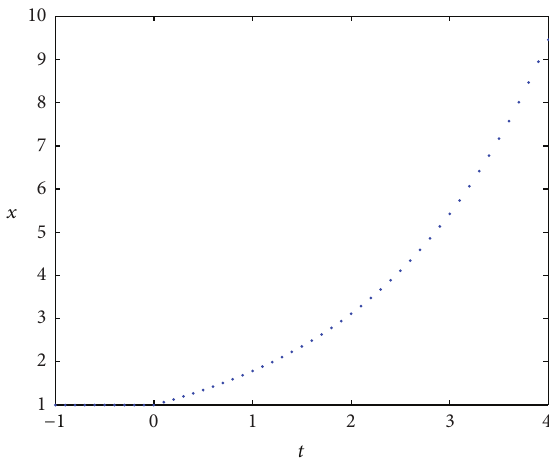
Figure 1: The solutions of (29), as Φ ≡ 1 , ℎ = 1/10 . Figure 2: The solution of (30) as Φ(𝑡) ≡ 1 , 𝑡 ∈ [−𝜏,0] .